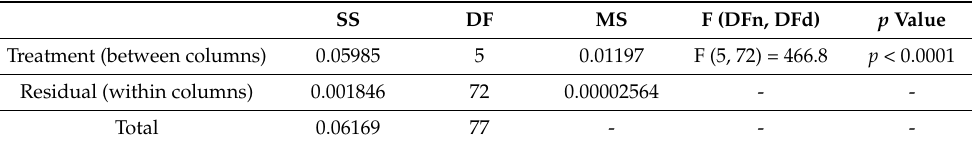
Table 11. ANOVA table of the proposed BO-CNN model vs. pre-trained-CNN models for the OCT dataset.